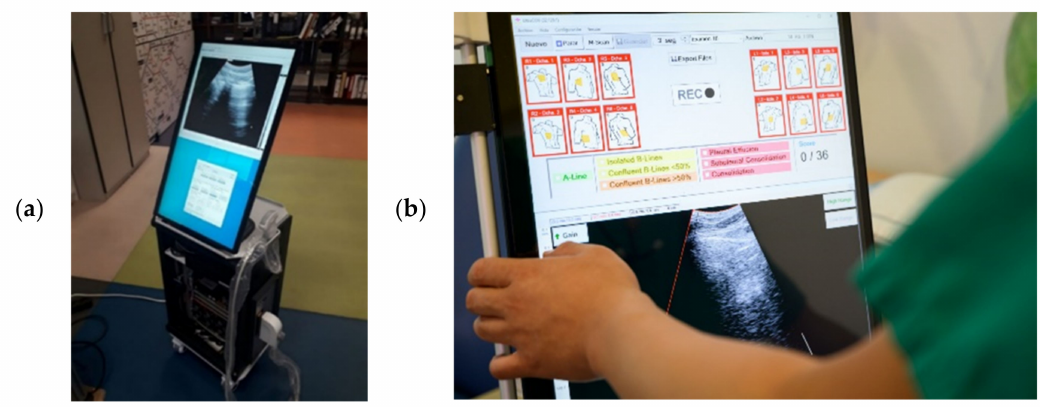
Figure 1. ( a ) UTRACOV scanner prototype and ( b ) screenshot of the acquisition